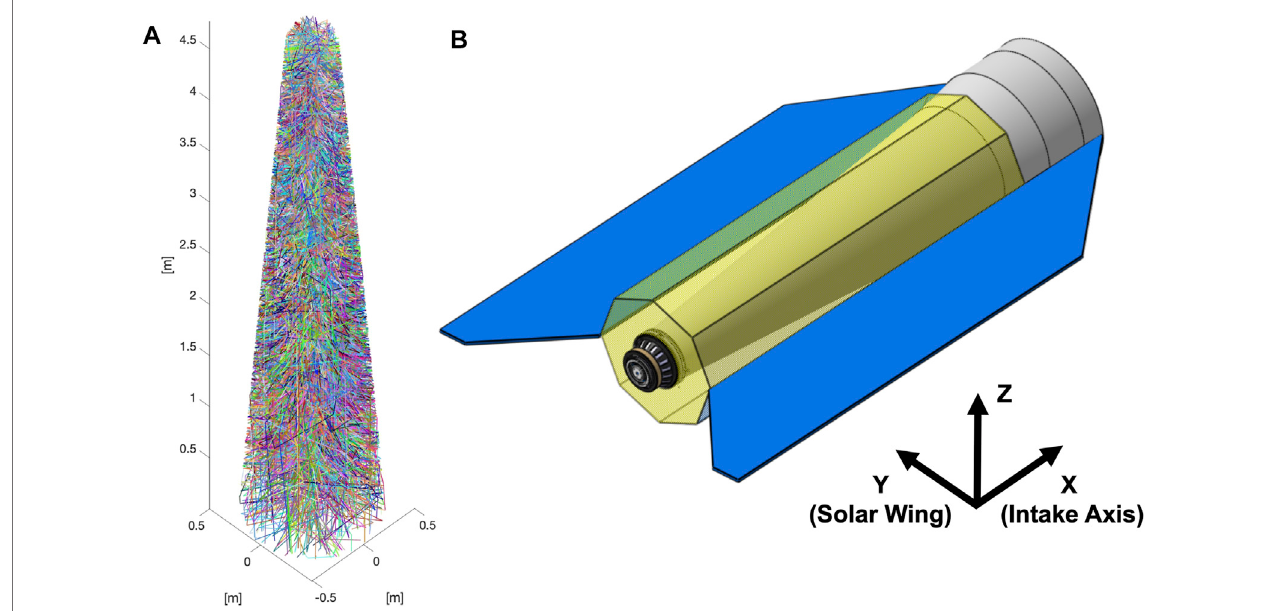
FIGURE7|(A) Exampleofconicalintake,including100simulatedparticletrajectories. (B) Impression ofintakeintegration inaGOCE-likeplatformandde fi nitionof a body- fi xed reference frame.